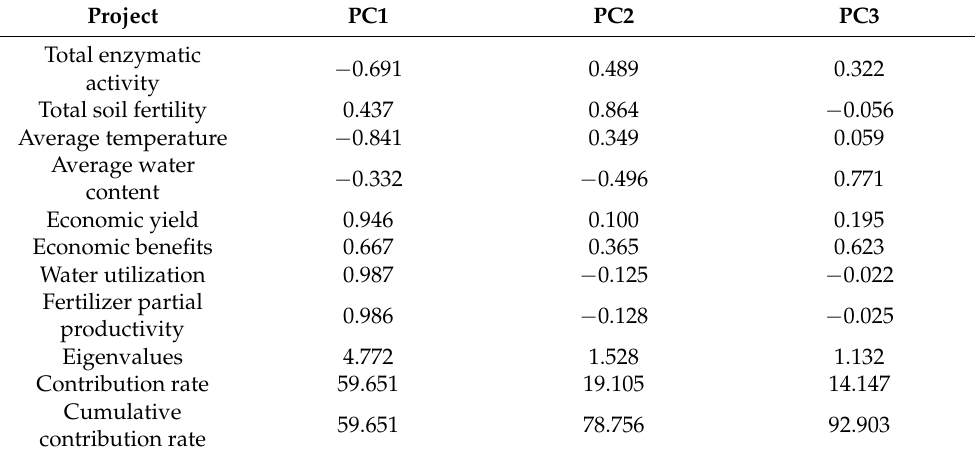
Table 4. Principal component analysis rotation factor loading, eigenvalues, and cumulative vari- ance